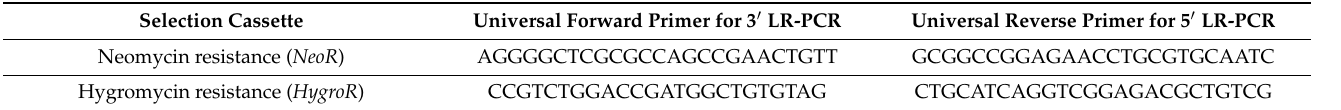
Table 1. sequence of universal primers currently used in the lab. Selection Cassette Universal Forward Primer for 3 (cid:48) LR-PCR Universal Reverse Primer for 5 (cid:48) LR-PCR Neomycin resistance ( NeoR ) Hygromycin resistance ( HygroR